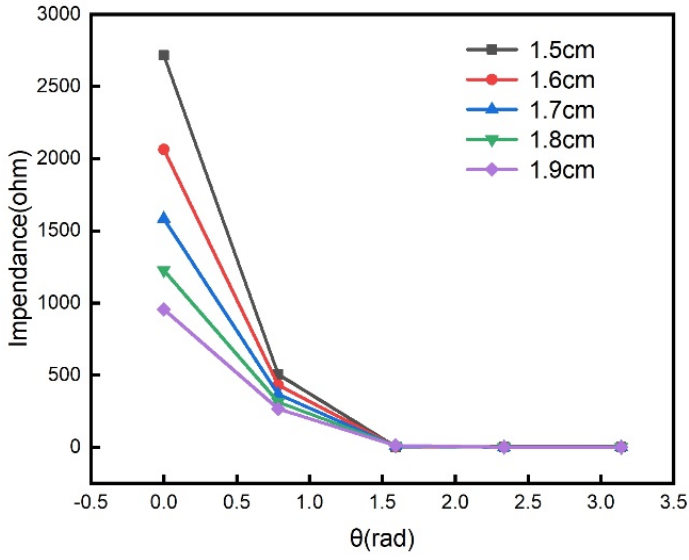
Figure 4. The amplitude of impedance as a function of rotation angle under different coupling dis- tances.